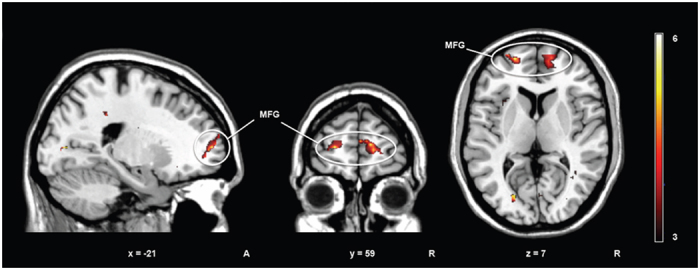
Whole brain activity correlating with eccentricity. Eccentricity is a psychophysical kernel property that describes visual detection as ratio between stimuli with large and small deviation from the expected trajectory. Within regions where activity was increased during explicit detection, the most significant clusters corresponded to the left and right middle frontal gyrus (BA10, −27, 47, 7; 30, 41, 13).